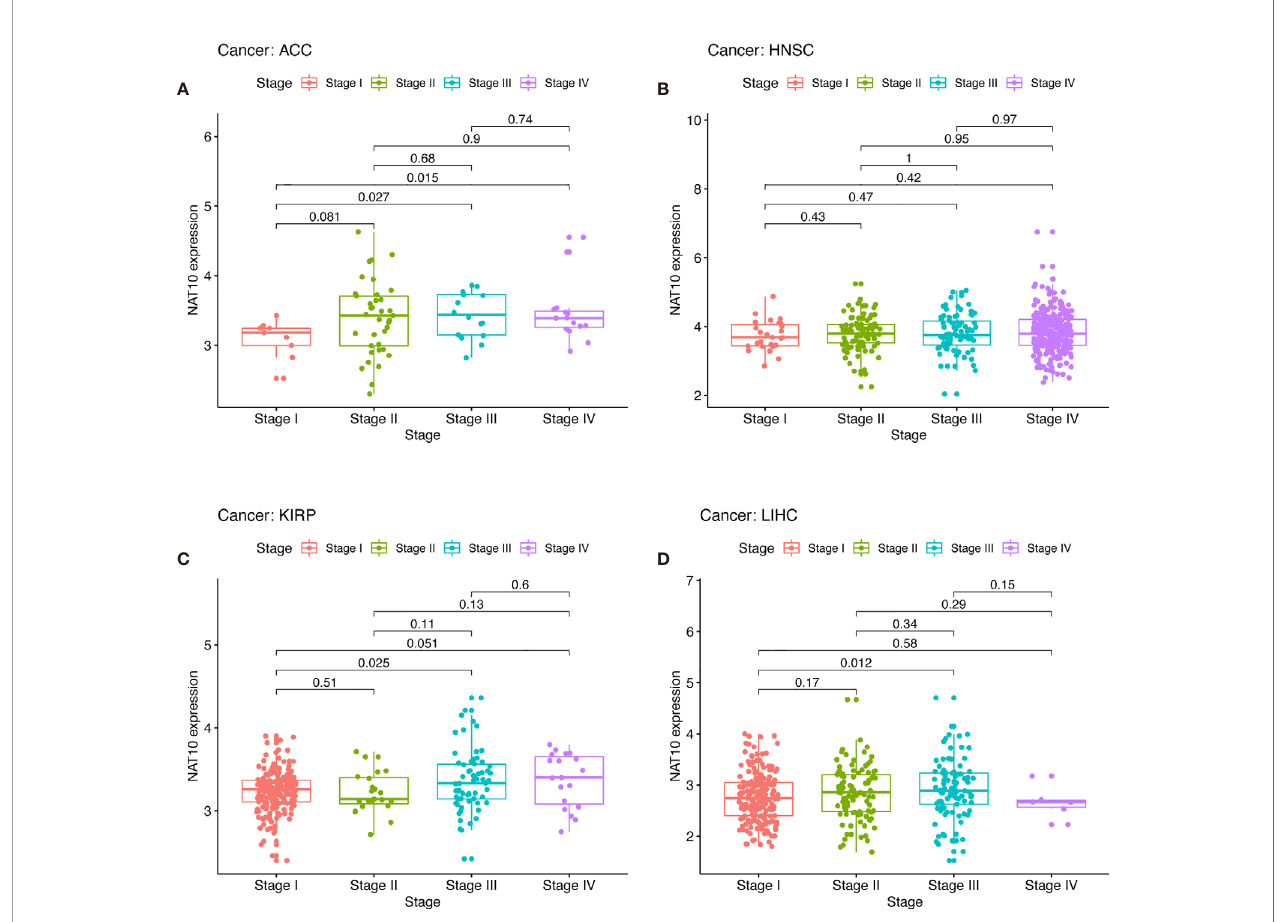
FIGURE 4 | Correlation of NAT10 expression levels with stage in ACC, HNSC, KIRP, and LIHC. Relationships of NAT10 expression with stage in ACC (A) , HNSC (B) , KIRP (C) , and LIHC (D)